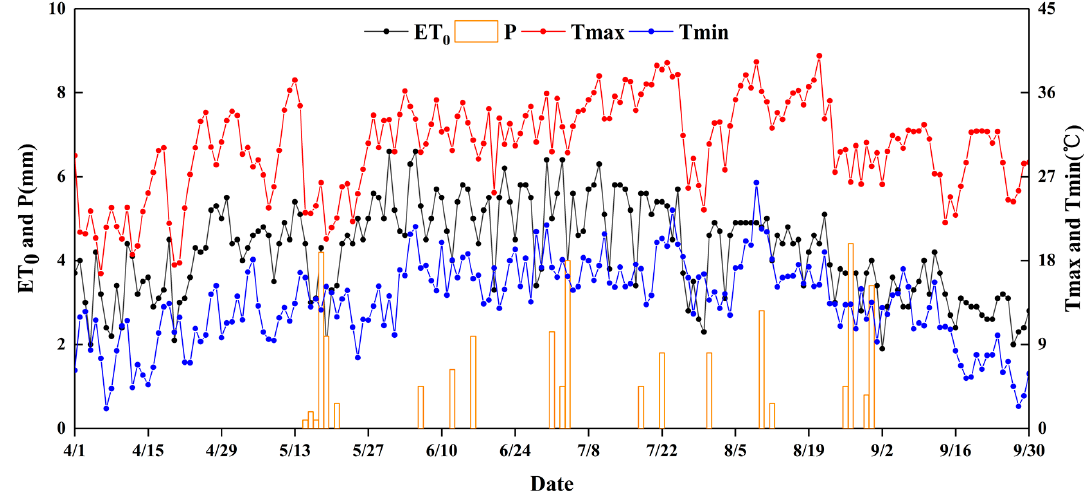
Figure 3. Meteorological data for 2018.